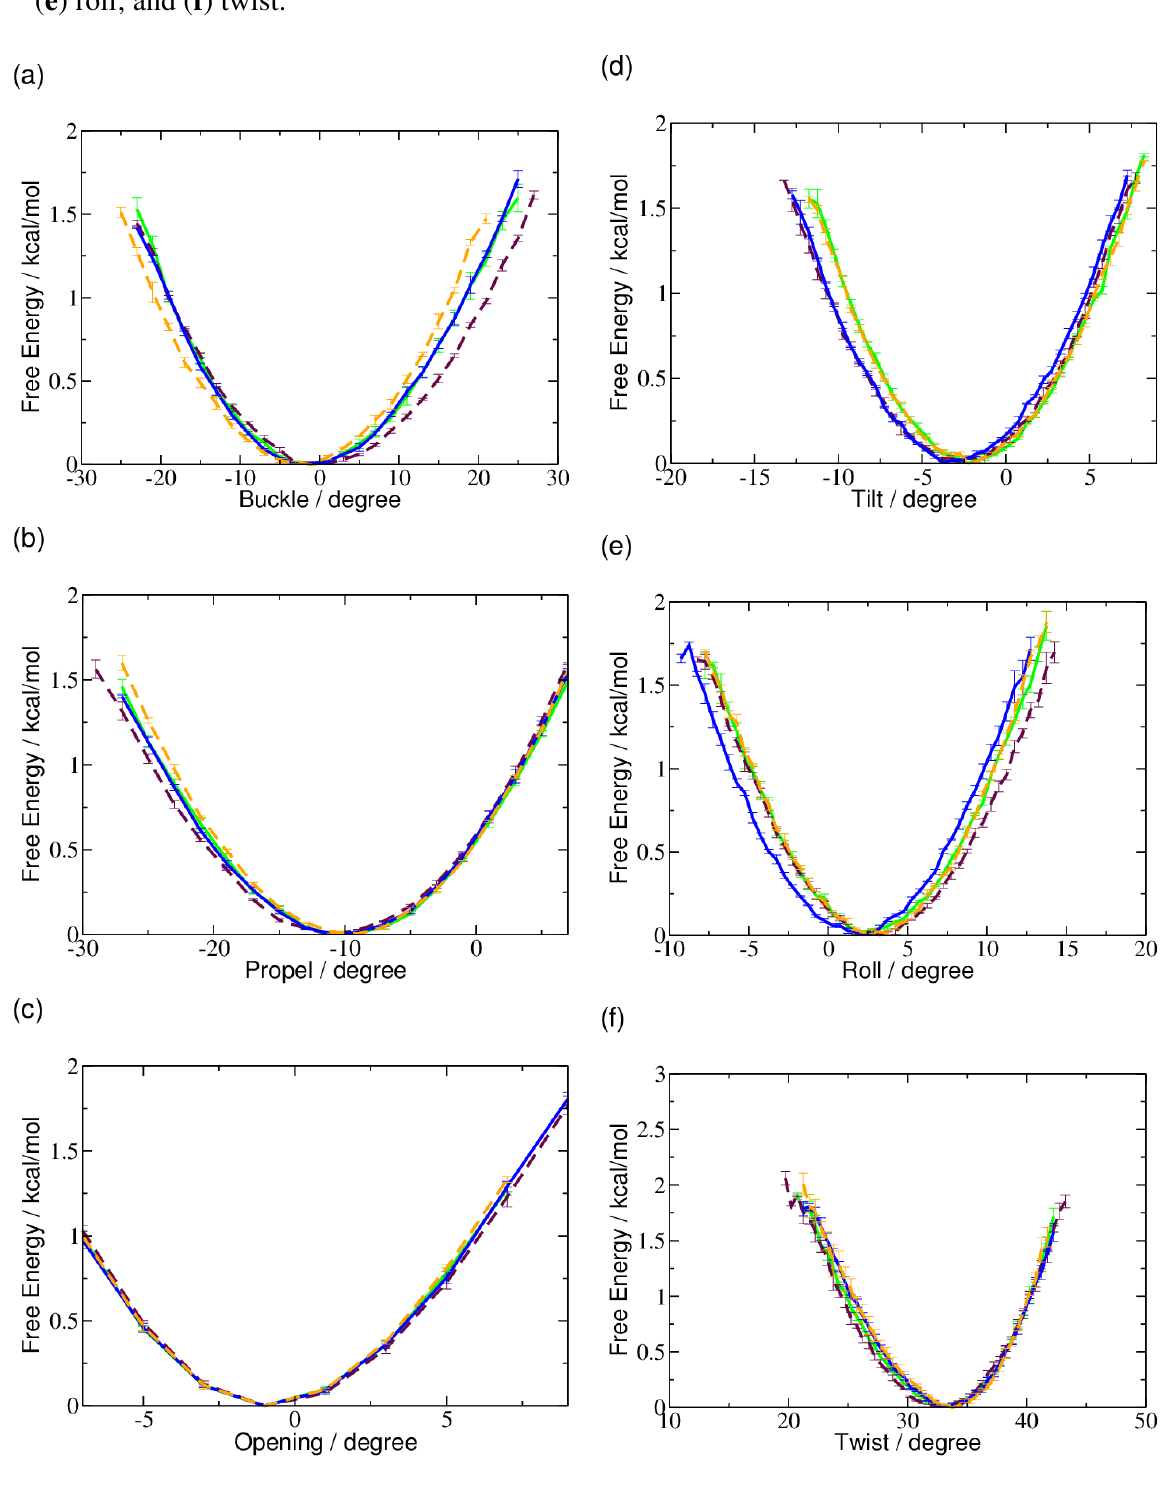
Figure 1. Free energy profiles of local helical rotational parameters of 5-methyl-cytosine (green), 5-hydroxymethyl-cytosine (maroon), 5-formyl-cytosine (blue) and 5-carboxyl- cytosine (orange), respectively: ( a ) buckle; ( b ) propeller twist; ( c ) opening; ( d ) tilt; ( e ) roll; and ( f )